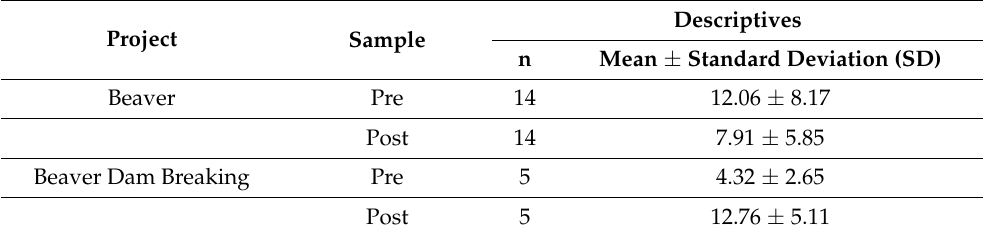
Table 1. Salivary Cortisol (nmol/L) Descriptives for Pre- and Post-Participation in